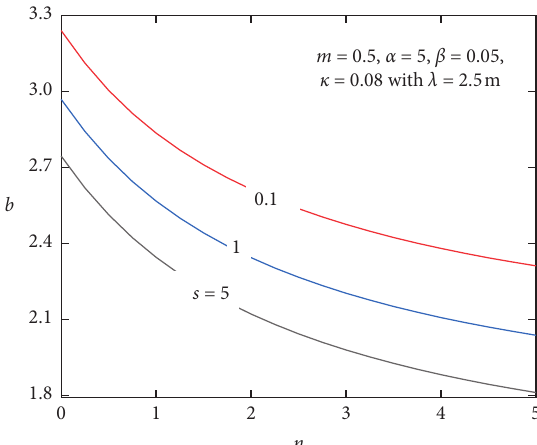
Figure 5: Dependence of the dimensionless buckling load b on the stiffness ratio n of the linear lateral stiffness, for different friction ratios s .